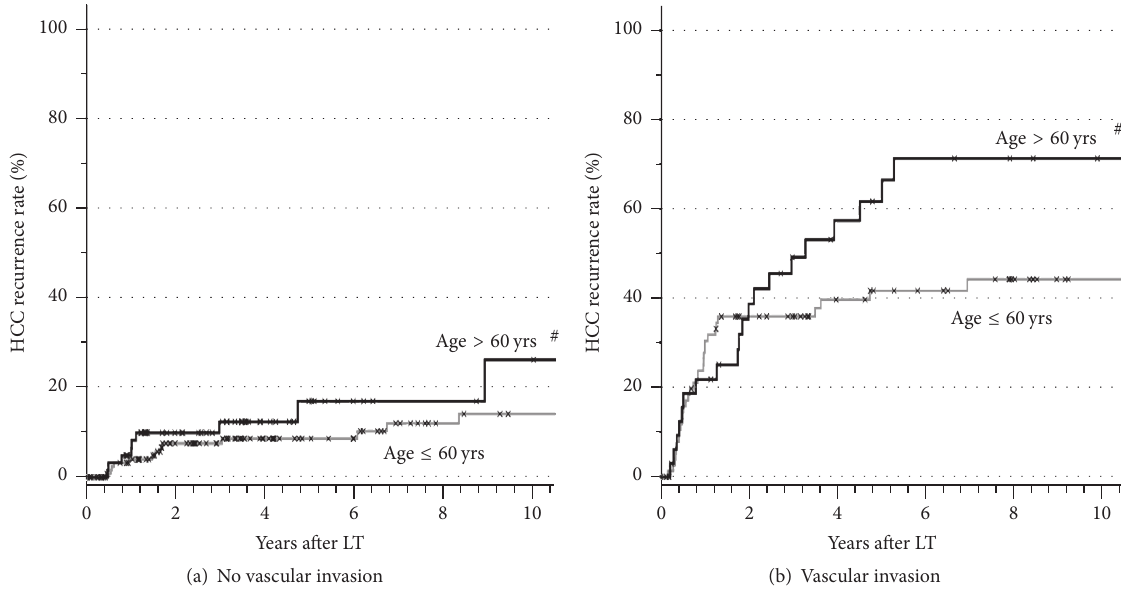
Figure 1: HCC recurrence rates in patients without (a) and with (b) microvascular invasion in correlation with the recipient’s age at transplantation ( # 𝑝 < 0.05 age ≤ 60 versus age > 60 tested by stratified log rank test).